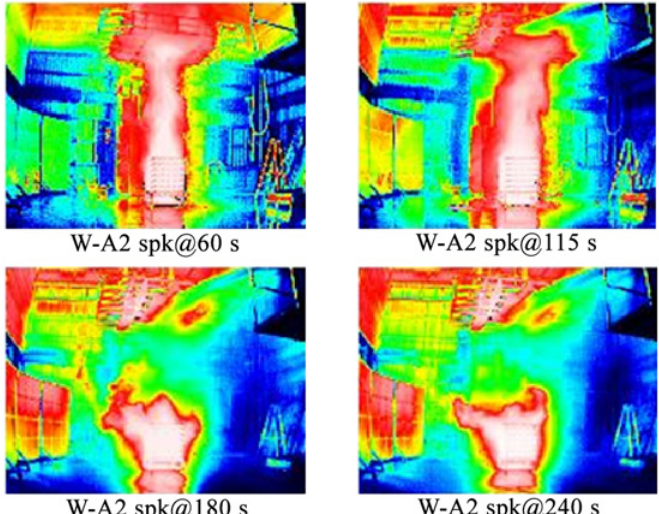
Fig 15. Temperature distribution of experiment results (for Case W-A2